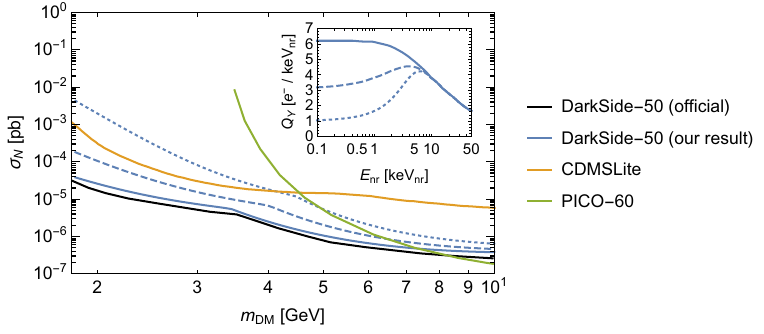
Figure 8 . Direct detection constraints on low-mass DM. For our reanalysis of DarkSide-50 we consider variations in the functional form of the ionisation yield Q y as shown in the